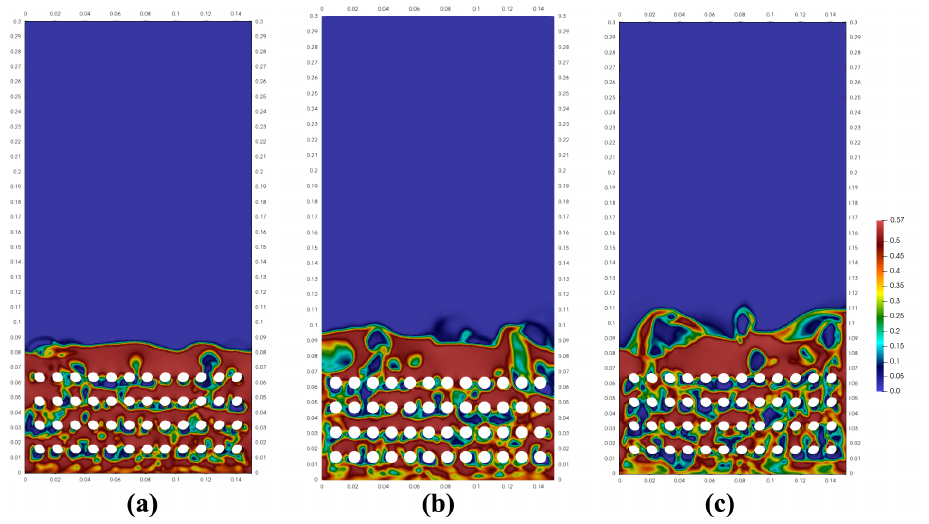
Figure 10. Profile of the solid volume fraction with different fluidization gas inlet rate; ( a ) 0.245 g/s,